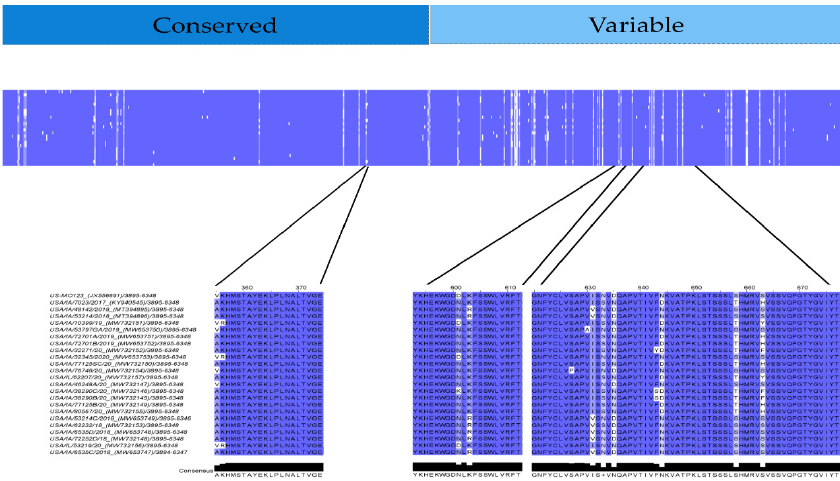
Figure 8. Capsid protein percent identity plot of USA PoAstV3 from this study. Blue and white areas indicate areas of higher and lower homology, respectively. Amino acid homology of linear epitopes and probable antigens of USA PoAstV3 strains identified in this study.